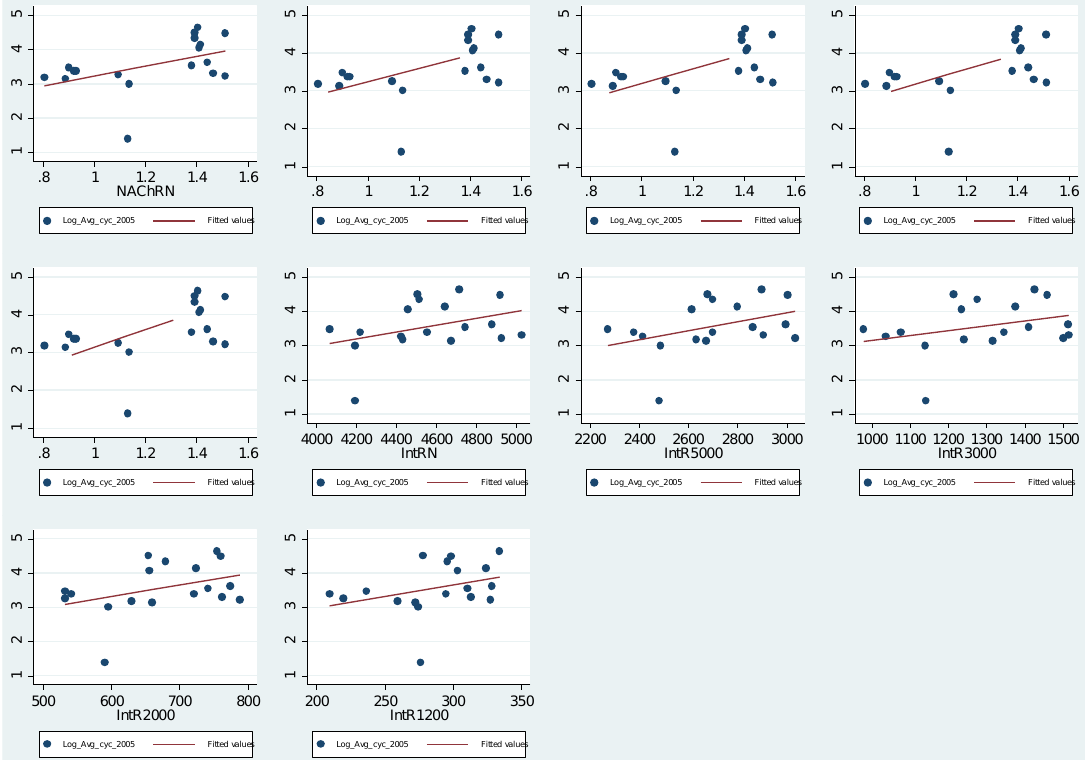
Figure 14. The figure highlights the Log-Log Scatterplots between Log cyclists’ movement 2003 and different radii of Space Syntax